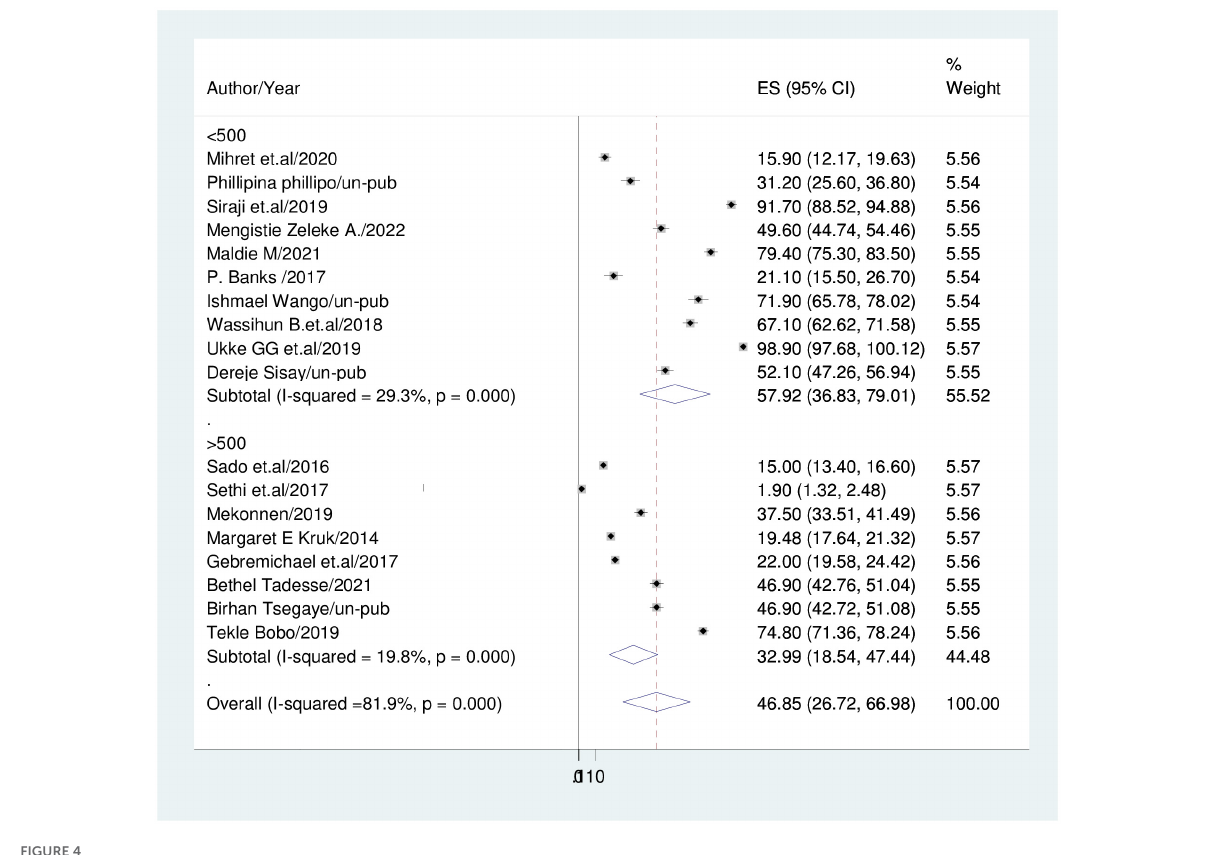
publication bias when eight papers were included in the funnel plot ( Figure 6 ).